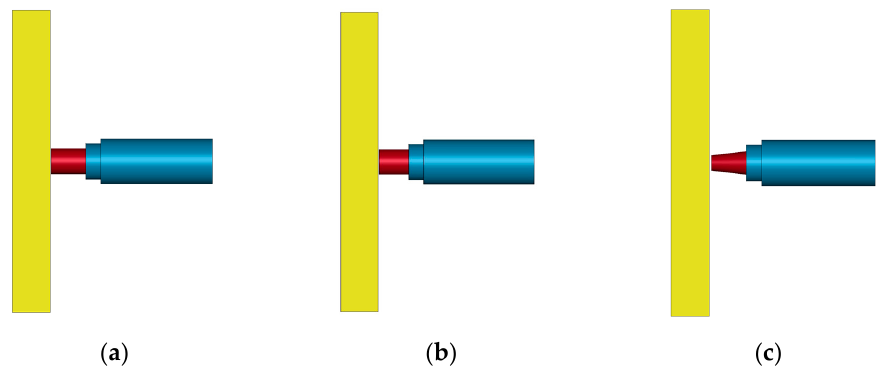
Figure 2. Residual velocity numerical simulation test model. ( a ) The 11/17 conventional projectile. ( b ) The 13.5/17 conventional projectile. ( c ) Truncated cone PELE projectile. Table 1. JOHNSON_ COOK parameters.